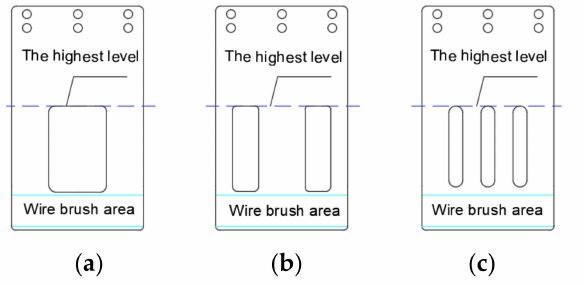
Figure 16. Three different types of brush plates with different numbers of